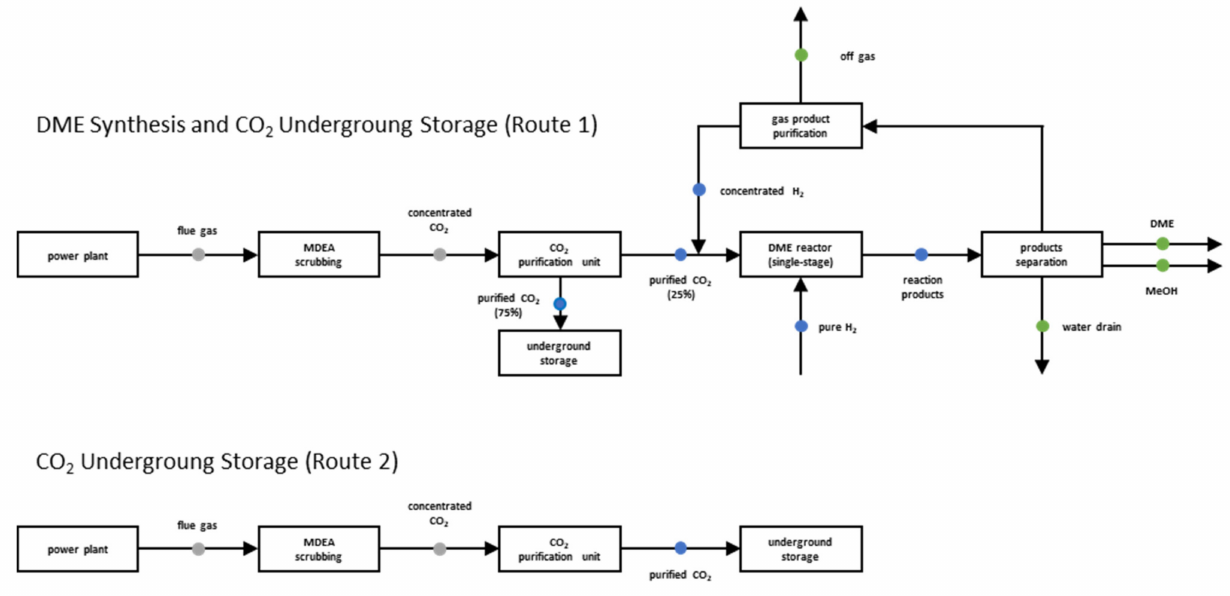
Figure 3. Configuration of the proposed solution ( top ) and of the comparison